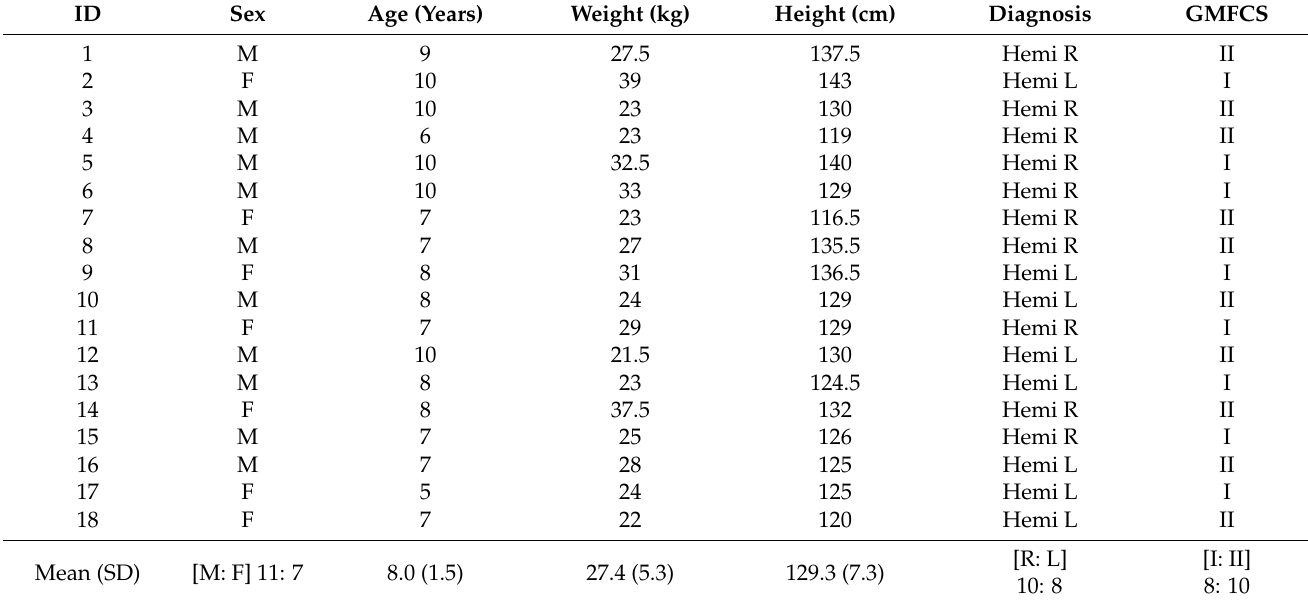
Table 1. Participants characteristics. They were classified according to gender, age, weight, height, diagnosis, and GMFCS (Gross Motor Function Classification